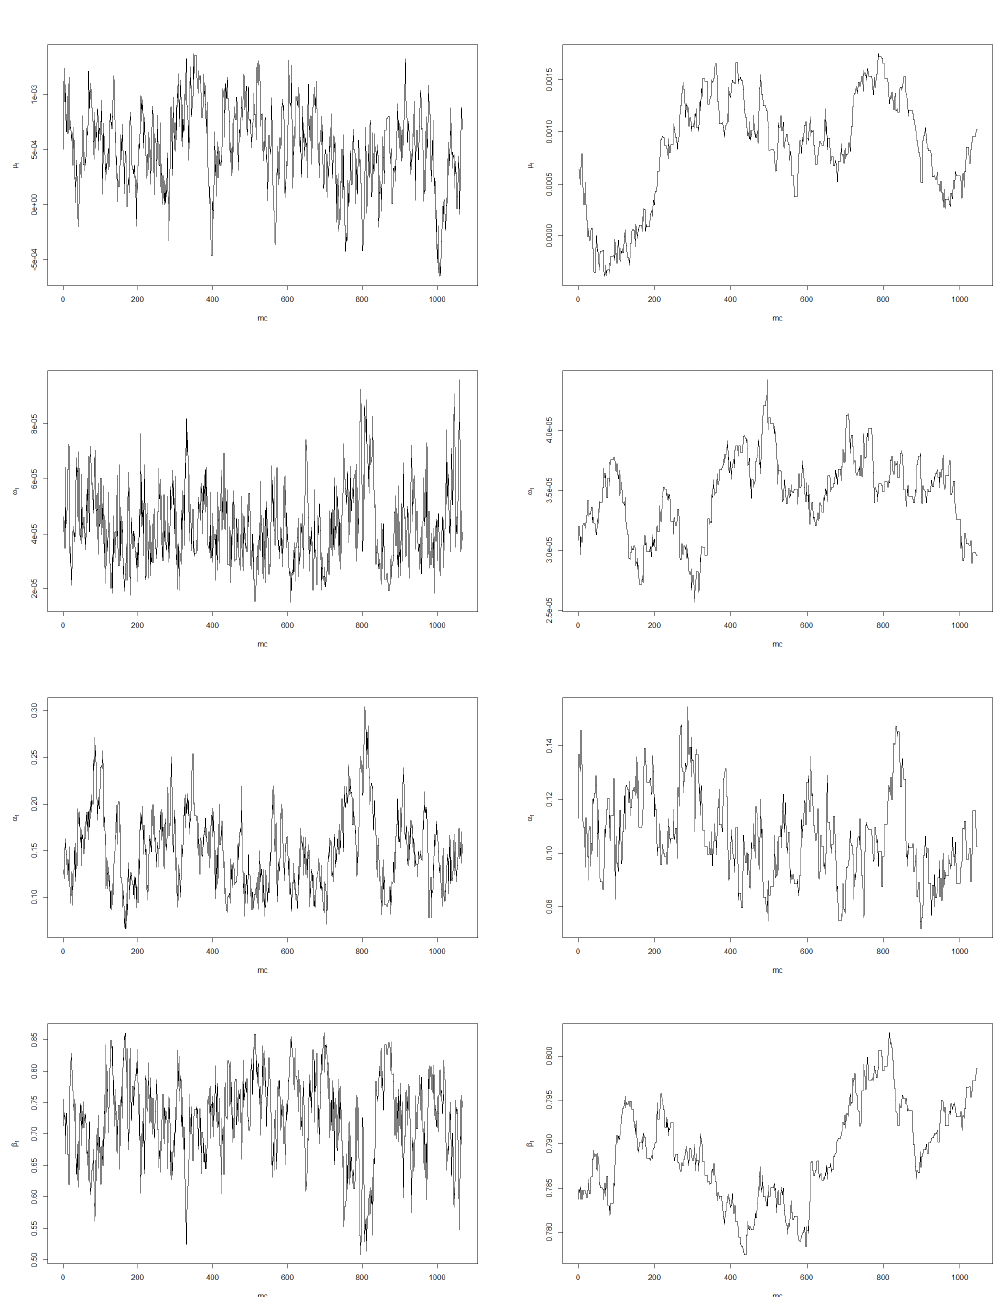
Figure 4: Chains of parameter draws for µ 1 , ω 1 , α 1 , and β 1 ; CHMC (left) and RW-MCMC